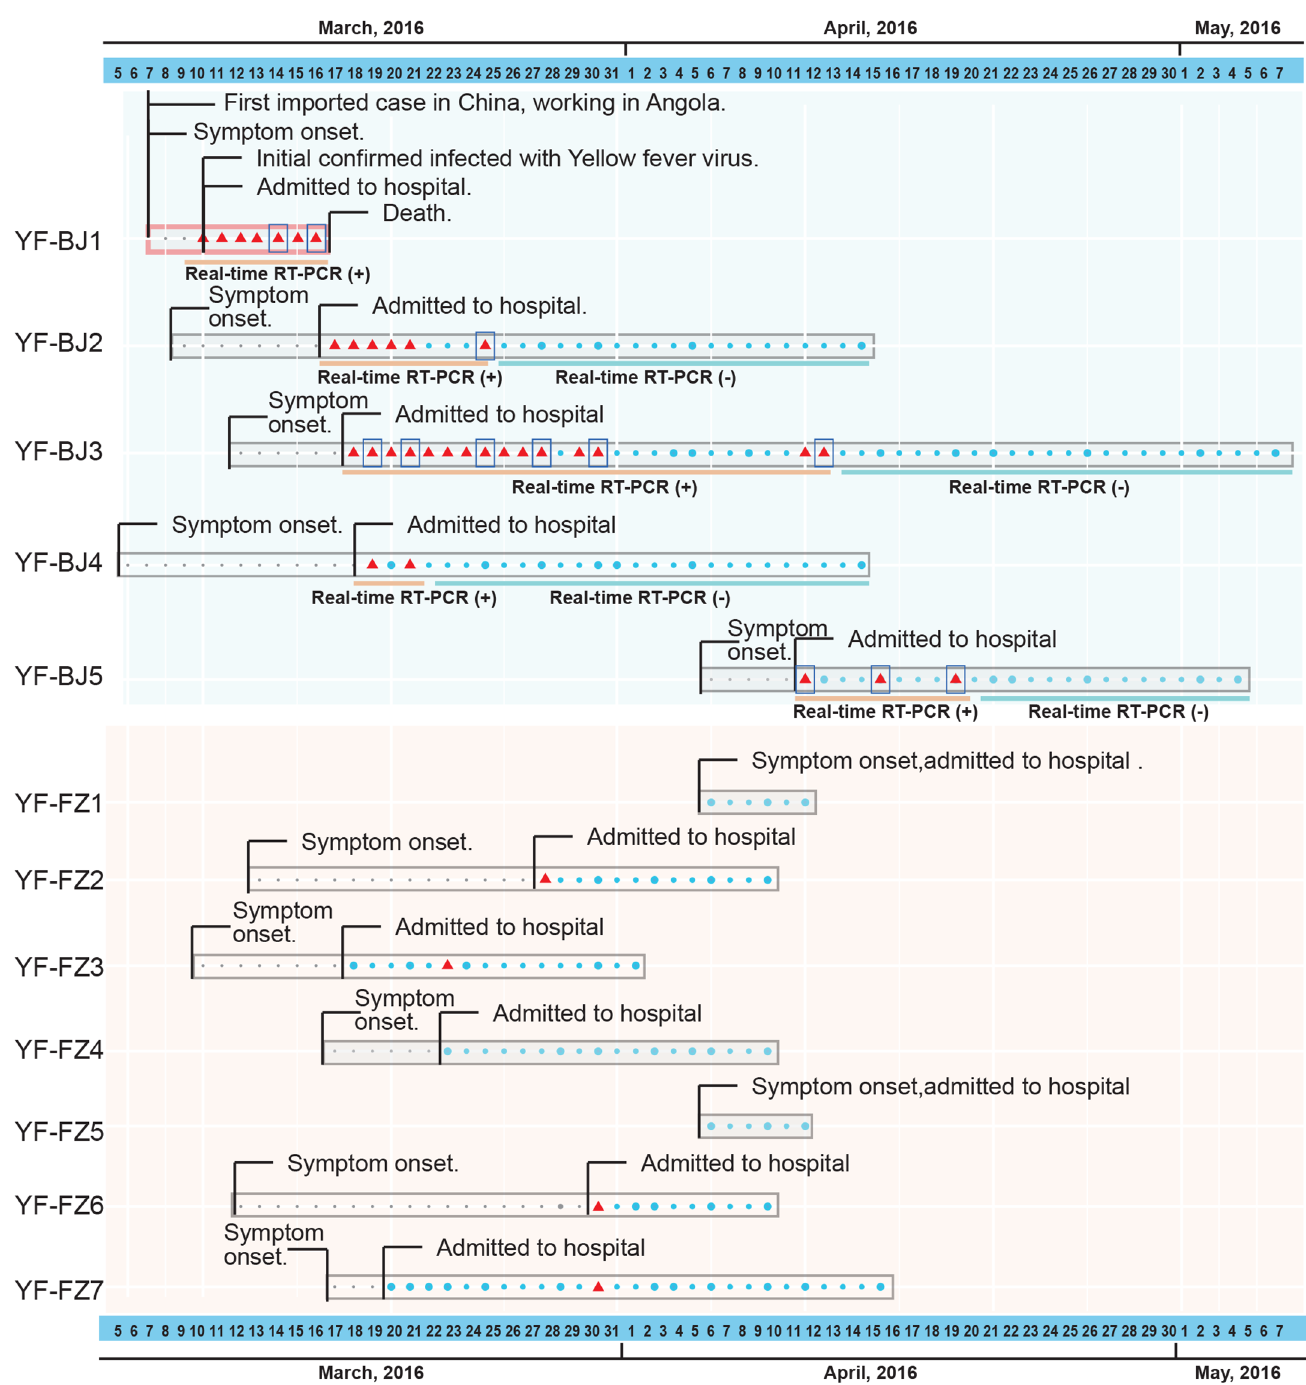
Fig 1. Cases of twelve documented returning YFV patients in China by date in the outbreak of Angola from March to May 2016. Timeline of events for each patient from symptom onset to the leaving from hospital are shown with different molecular detection methods and results. Dots denote that we did not get any positive molecular detection result in the time point, grey (before admitted to hospital) and blue (after admitted to hospital). The larger size dots means that we performed Real-time PCR detections in that point. The red triangles denote the sample have been detected by PCR and Real-time PCR with positive results. Blue boxes denote the samples that were subjected to NGS analysis at the time